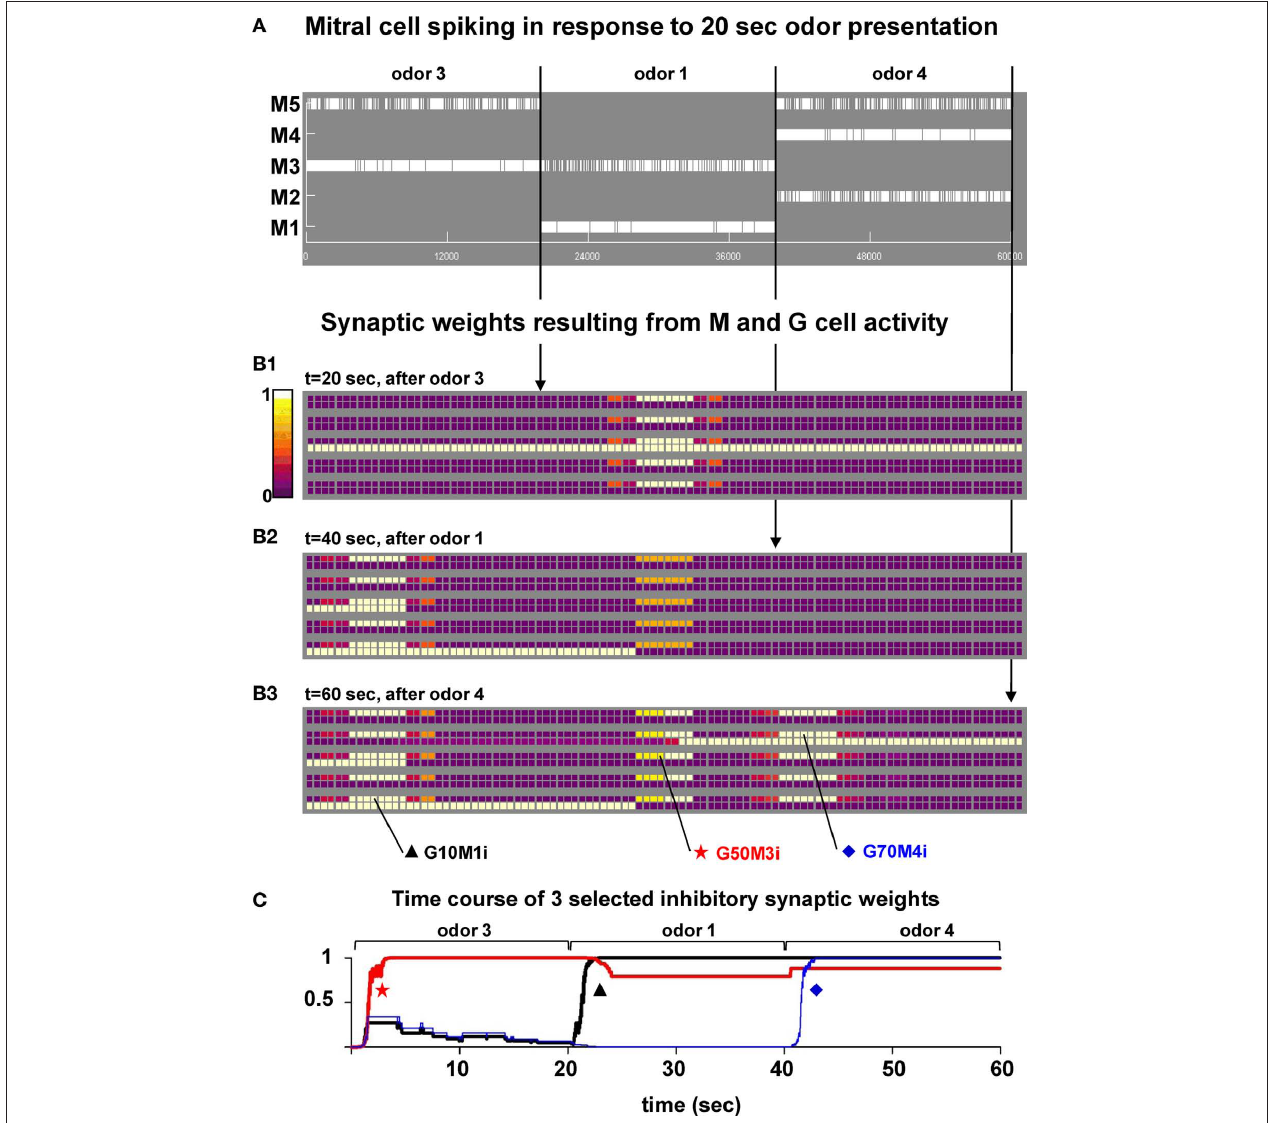
simulation. (C) Time course of the normalized inhibitory weight for three synapses (G10M1i, G50M3i, and G70M4i). The location of the synapses in the network is indicated in (B3) . A movie of this simulation is available as Supplementary Movie